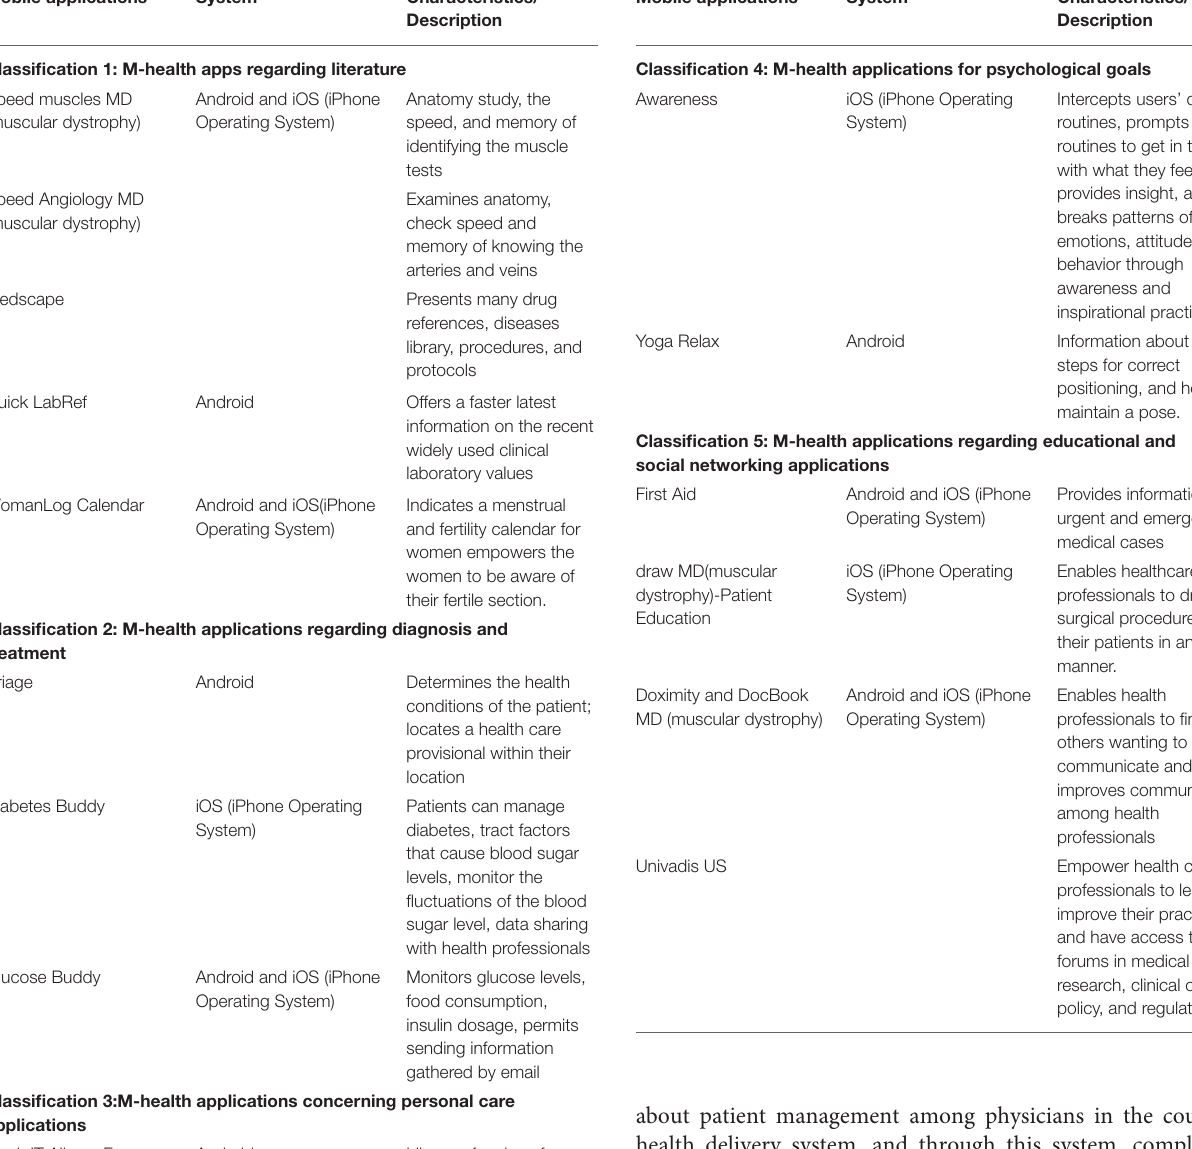
TABLE 1 | M-health application classifications and characteristics. Mobile